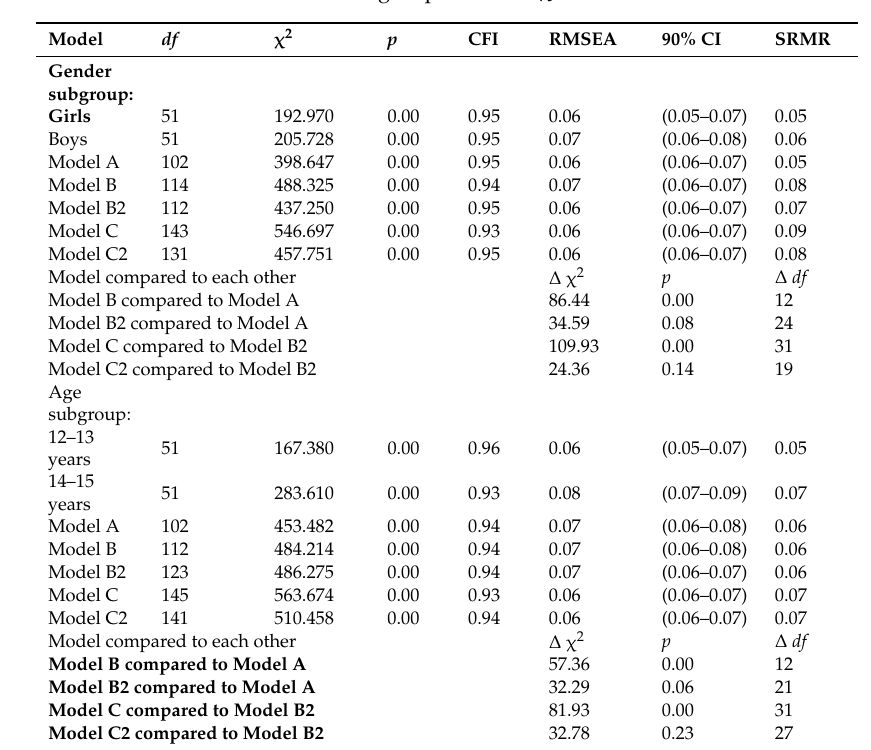
Table 3. Coefficients of total, direct, and indirect effects.